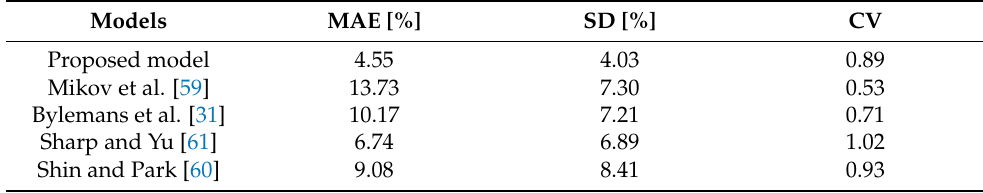
Table 6. Overall MAEs, SDs, and CVs of estimated walked distances achieved by the models.